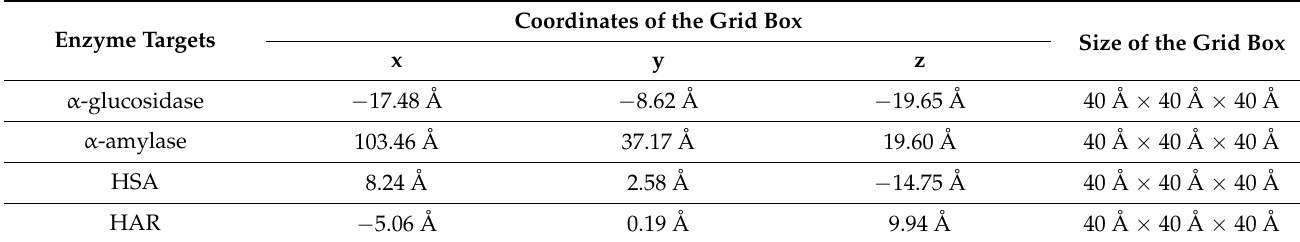
Table 1. The position of the grid box placed on binding pockets of the respective target proteins. Coordinates of the Grid Enzyme Targets